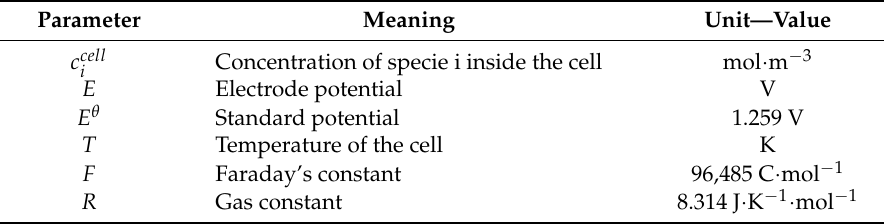
Table 1. Parameters and constants for Nerst Equation.